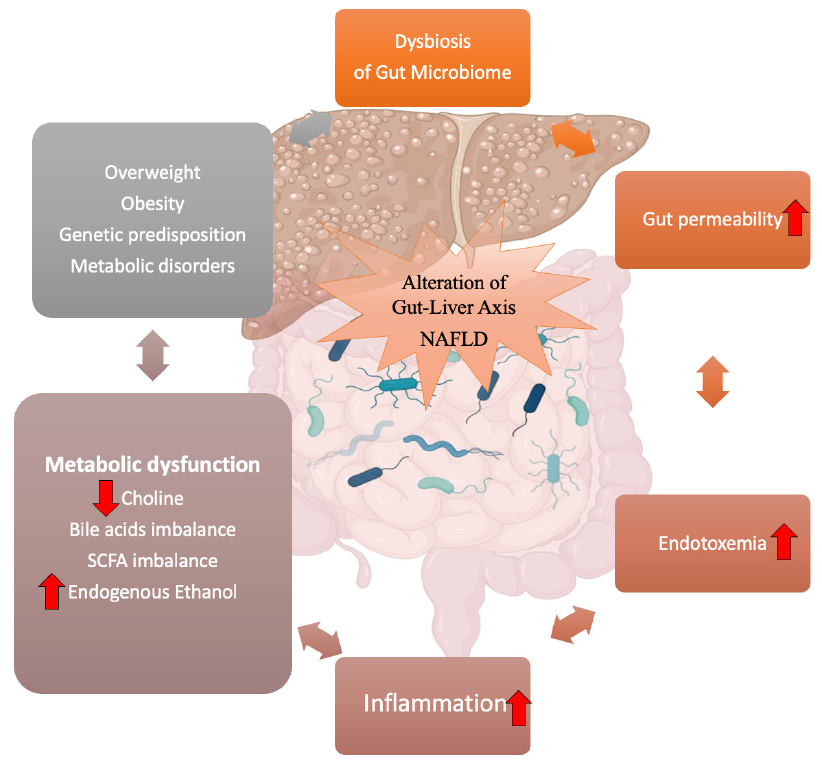
Figure 1. Gut–liver axis and NAFLD: a vicious circle of dysfunctions orchestrated by the gut microbiome. Alteration of the gut–liver axis is characterized by several pathological mechanisms, such as the impairment of the gut barrier and consequent increase of the intestinal permeability which result in endotoxemia and inflammation, and changes in bile acid profiles and metabolite levels (increasing of endogenous ethanol, reduction of choline levels, dysregulation of SCFA metabolism) produced by the gut microbiome. Gut microbiome dysbiosis has a prominent role in the disruption of the gut–liver axis. Created with https://BioRender.com (accessed on 10 October 2022) and modified with Microsoft PowerPoint v.16. SCFA: short-chain fatty acid; NAFLD: non-alcoholic fatty liver disease.